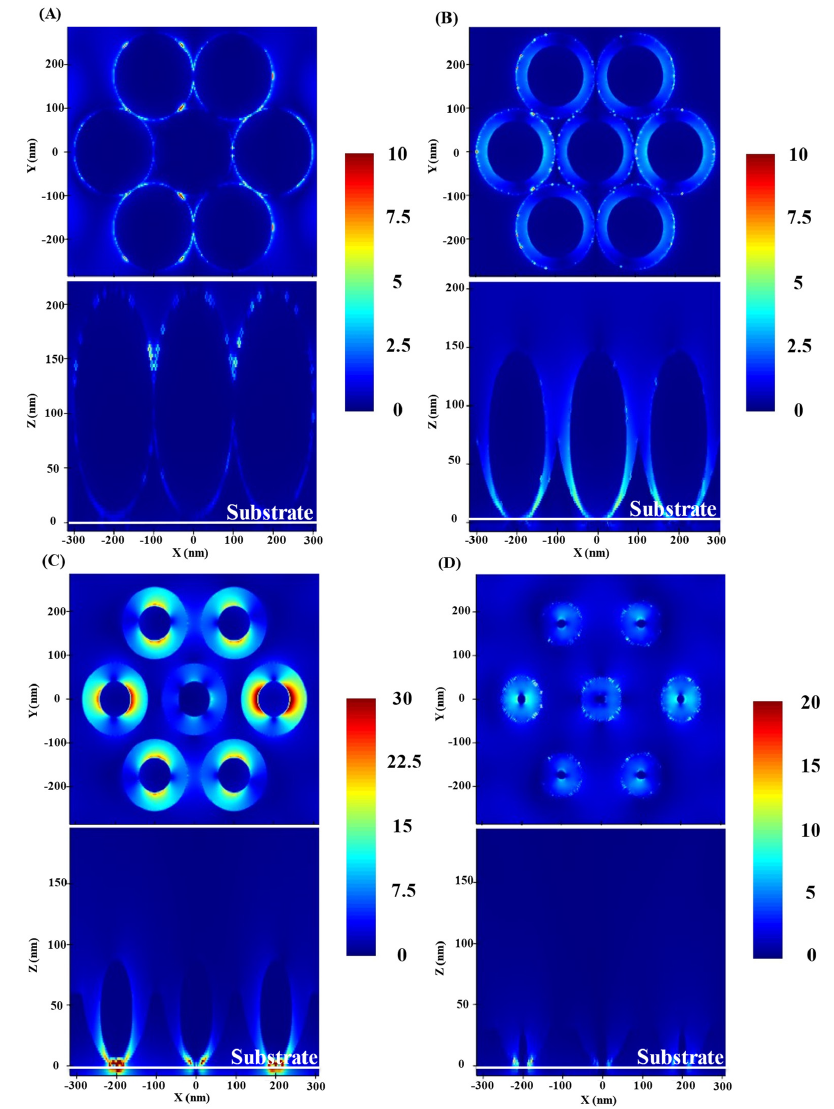
Figure 4. FDTD simulation results of ( A ) NC (etched for 0 s). ( B ) NCS (etched for 60 s). ( C ) NCR (etched for 120 s). ( D ) NPD (etched for 180 s). The top and bottom half of each diagram represent the top and side views of the simulation results, respectively.